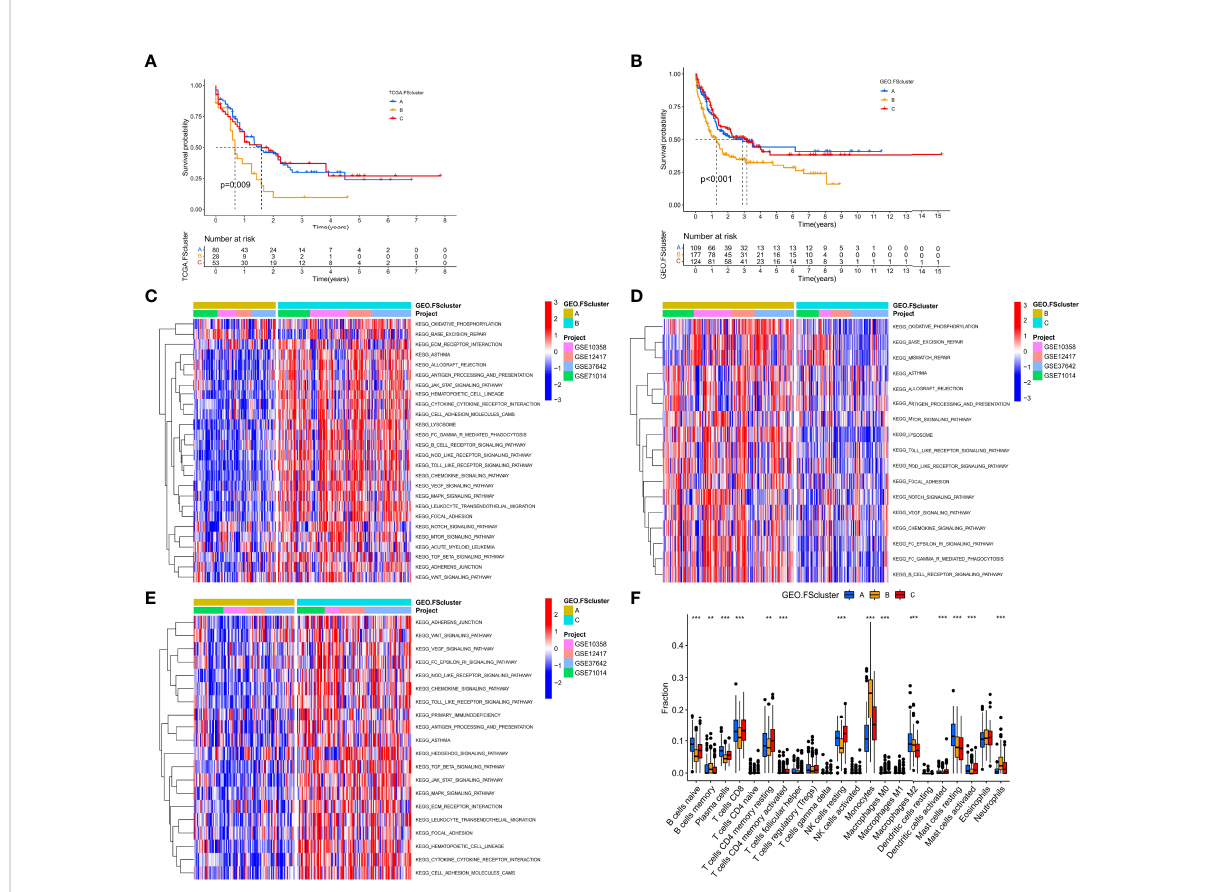
FIGURE 2 Survival analysis and biological characteristics analysis of ferroptosis-related molecular patterns. (A) Kaplan – Meier survival analysis of different ferroptosis-related molecular pattern groups in the TCGA cohort, log rank test. (B) Kaplan – Meier survival analysis of different ferroptosis-related molecular pattern groups in the GEO cohort, log rank test. (C – E) GSVA showed the activation levels of biological pathways in different ferroptosis-related molecular pattern groups in the GEO cohort. (F) The in fi ltration ratio of various TME cells in three ferroptosis-related molecular pattern groups in the GEO cohort, Kruskal – Wallis test, **P < 0.01; ***P <